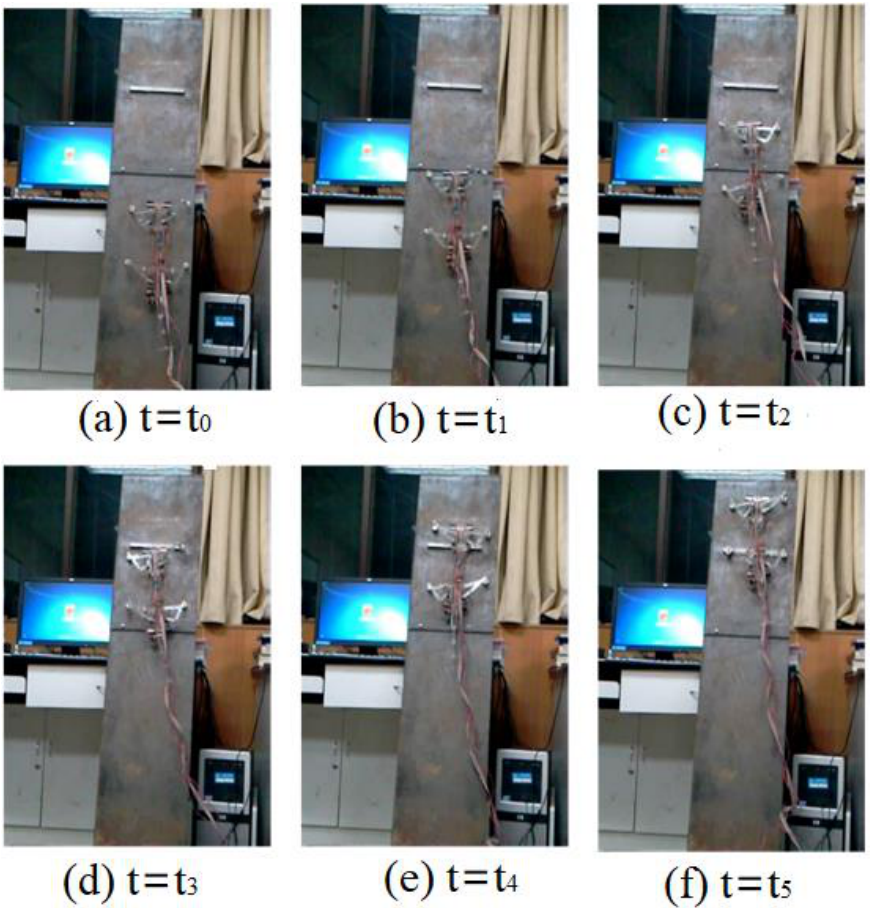
Figure 19. Video screenshot of the robot walking in a 90° complex environment in different mo-